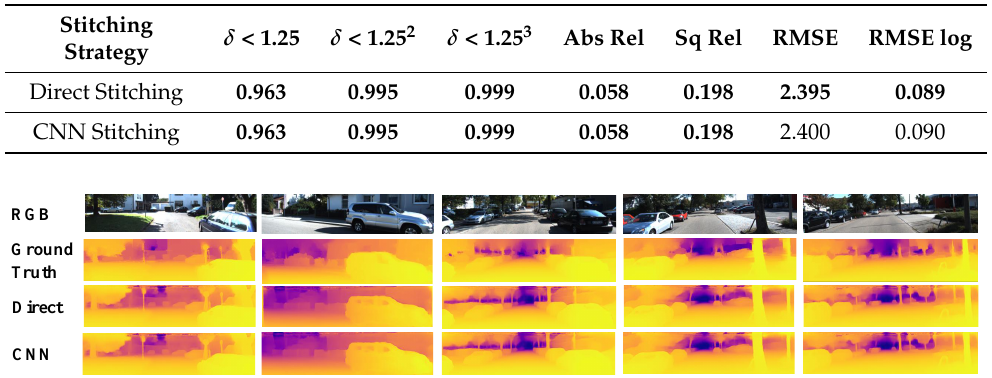
Table 3. The evaluation of our depth map stitching strategies.